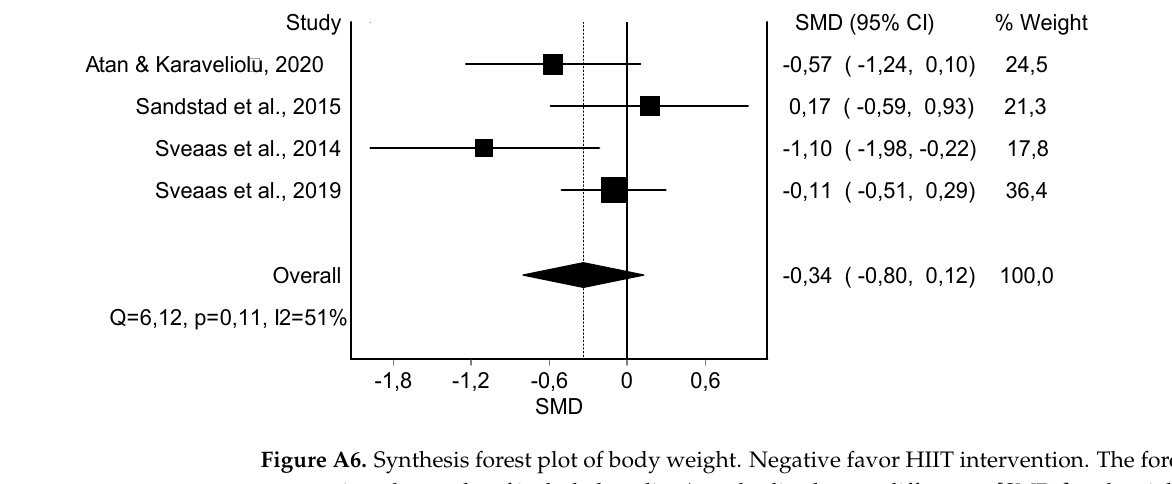
Figure A6. Synthesis forest plot of body weight. Negative favor HIIT intervention. The forest plot summarizes the results of included studies (standardized mean differences [SMDs] and weight). The small boxes with the squares represent the point estimate of the effect size and sample size. The lines on either side of the box represent a 95% confidence interval (CI).